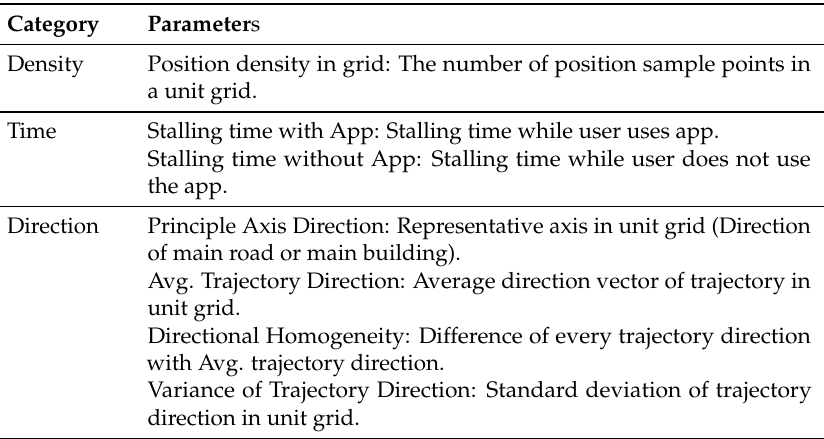
Table 2. Additional parameters for machine learning (non-spatial